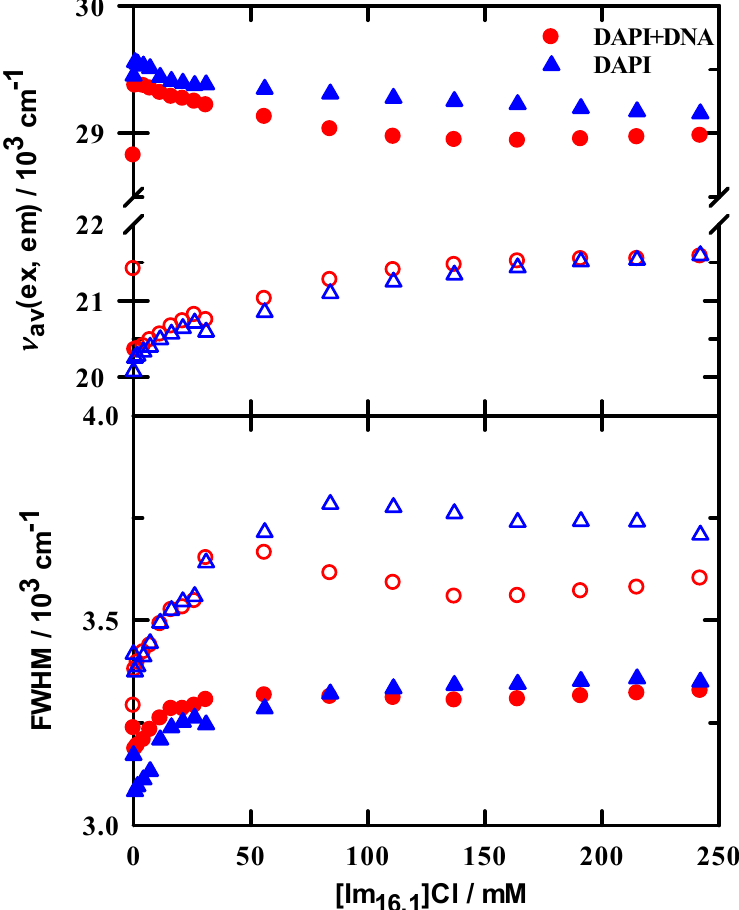
Figure 4. Steady-state excitation (filled symbols) and emission (open symbols) for DAPI + DNA duplex (circles) and DAPI (triangles) in 10 mM tris buffer at pH = 7.0 as a function of added IL. Upper panel: peak positions calculated from spectral first moments (intensity weighted average frequencies). Lower panel: full width at half maximum values of the intensity weighted spectra.